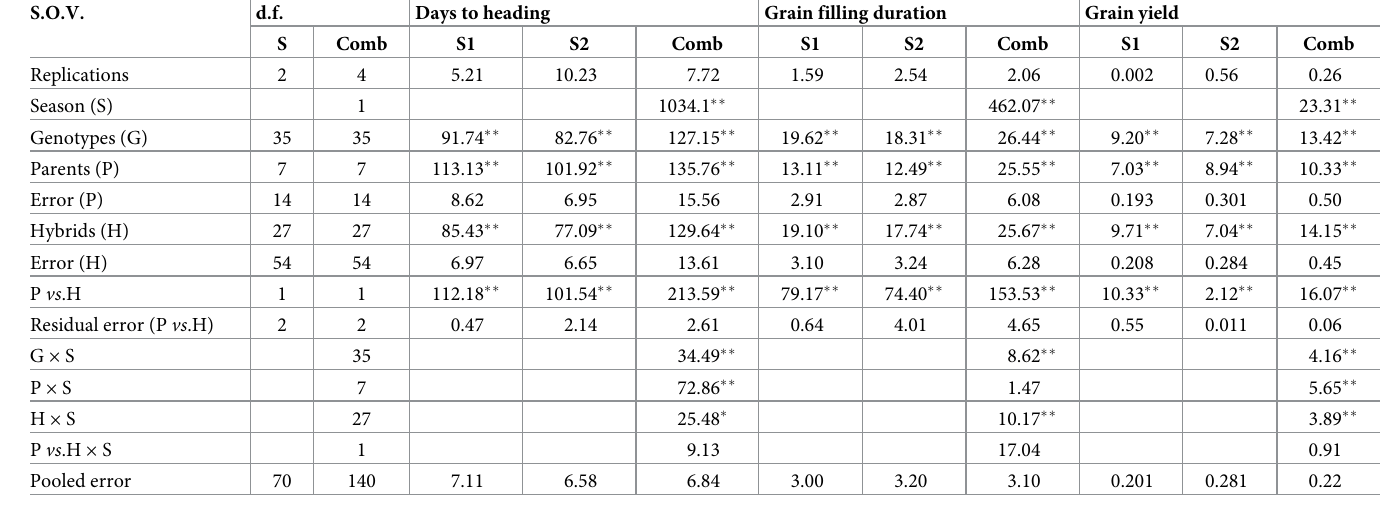
Table 2. Analysis of variance for days to heading, grain filling duration, and grain yield for each and across seasons of parents and their F 1 hybrids in bread wheat genotypes.